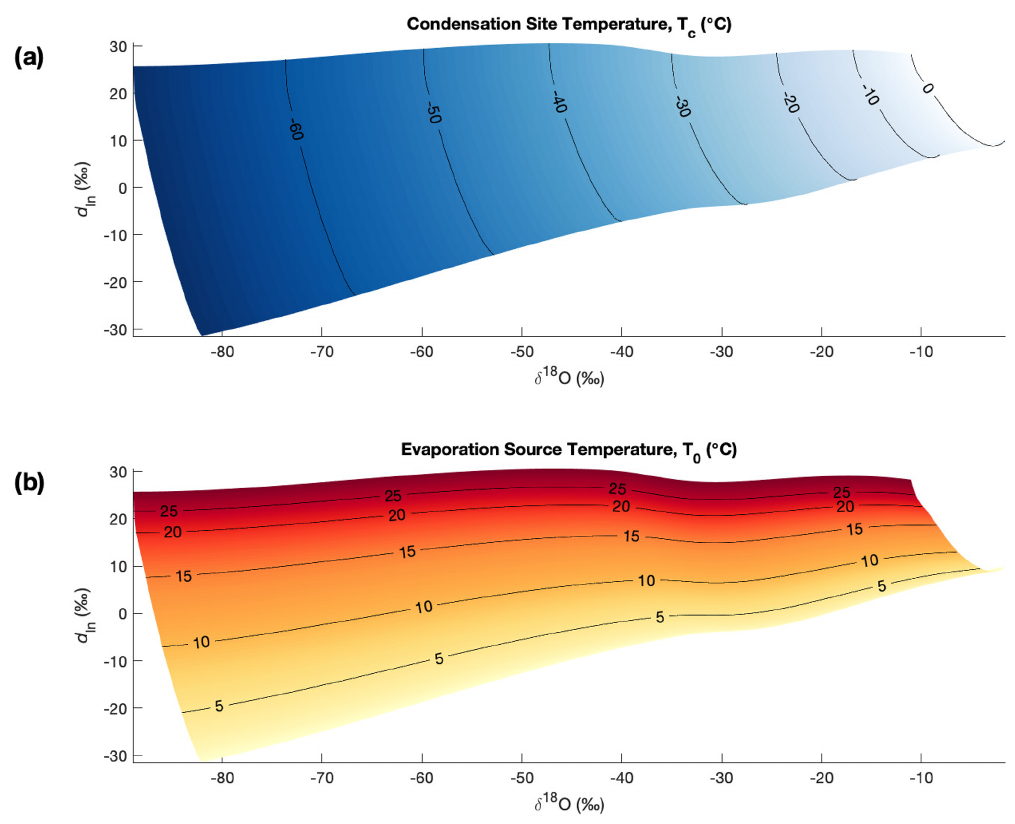
Figure 7. Inverted T 0 and T c surfaces as a function of modeled d ln and δ 18 O of precipitation. (a) Surface shading and contours show condensation site temperature, T c , in degrees Celsius ( ◦ C) as a function of d ln and δ 18 O of precipitation at a site. (b) Surface shading and contours show evaporation source temperature, T 0 , in degrees Celsius ( ◦ C) as a function of d ln and δ 18 O of precipitation at a